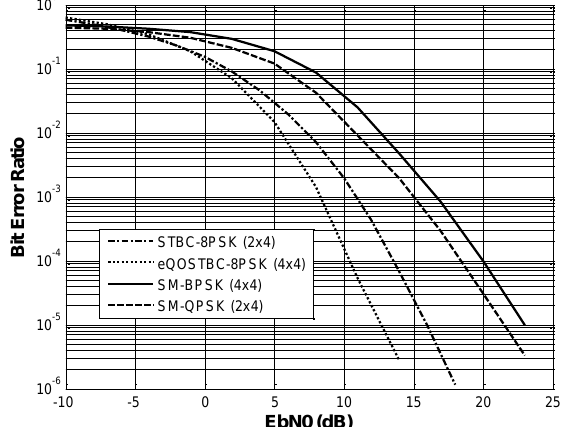
Figure 9: Comparison of three bits transmissions using SM, STBC and